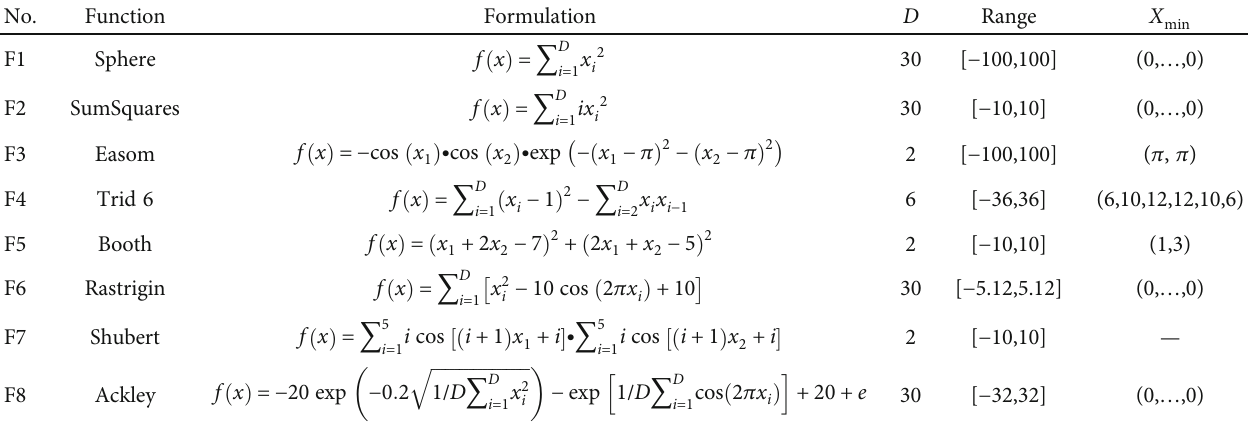
Table 2: Description of 8 benchmark functions.